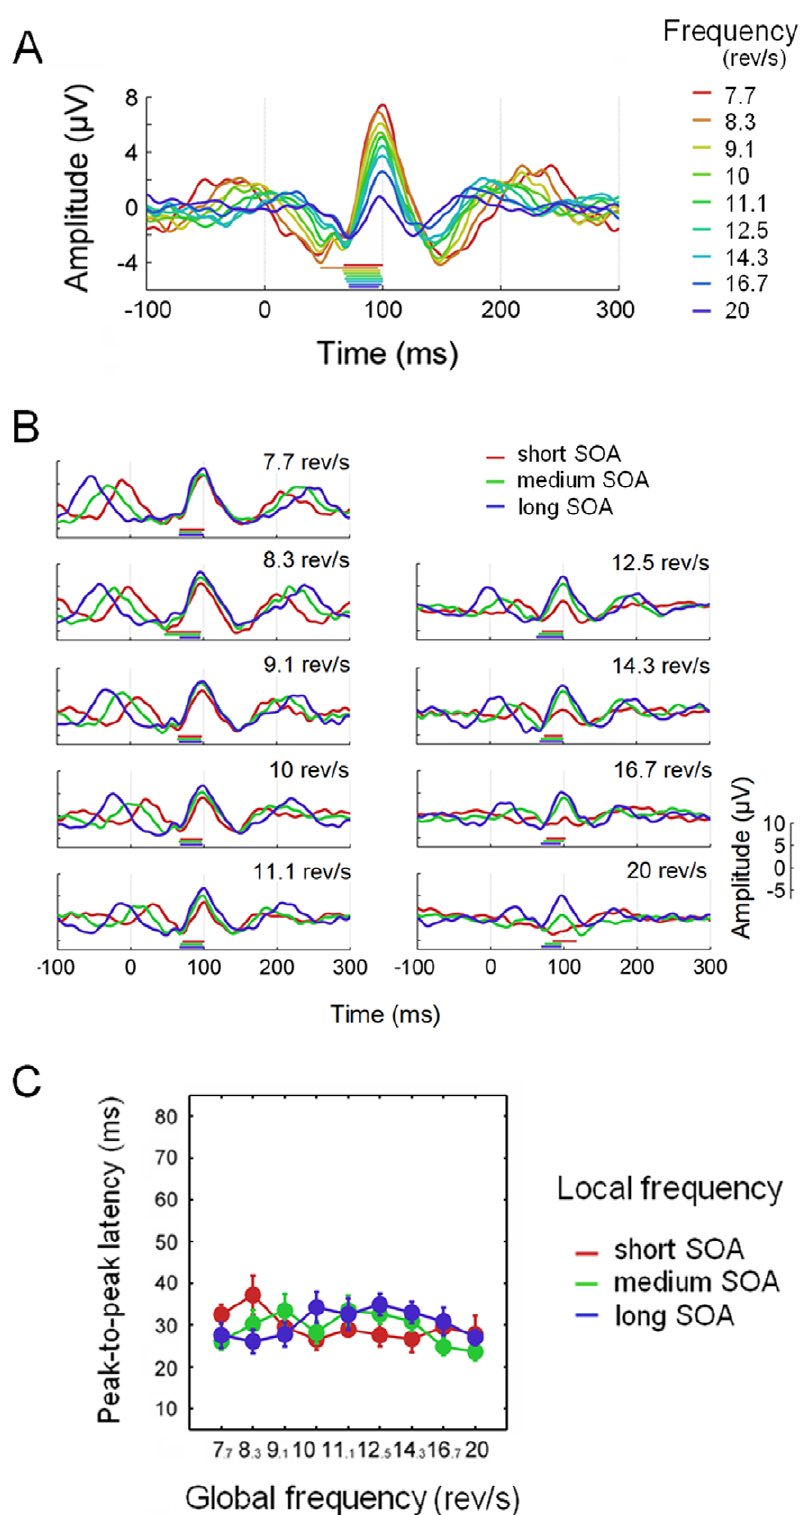
Figure 10. Effect of global and local stimulation frequency on the shape of recorded ERPs. A , Grand-average ERPs for the jitter conditions of Experiment 2. The solid bars along the horizontal axed indicate the peak-to-peak (N75-P100) latency. B , Grand-average ERPs for trials grouped by their immediately past SOA at each stimulation rate. C , Peak-to-peak latencies as a function of both global and local stimulation frequency. The error bars indicate the standard error of the mean across subjects.